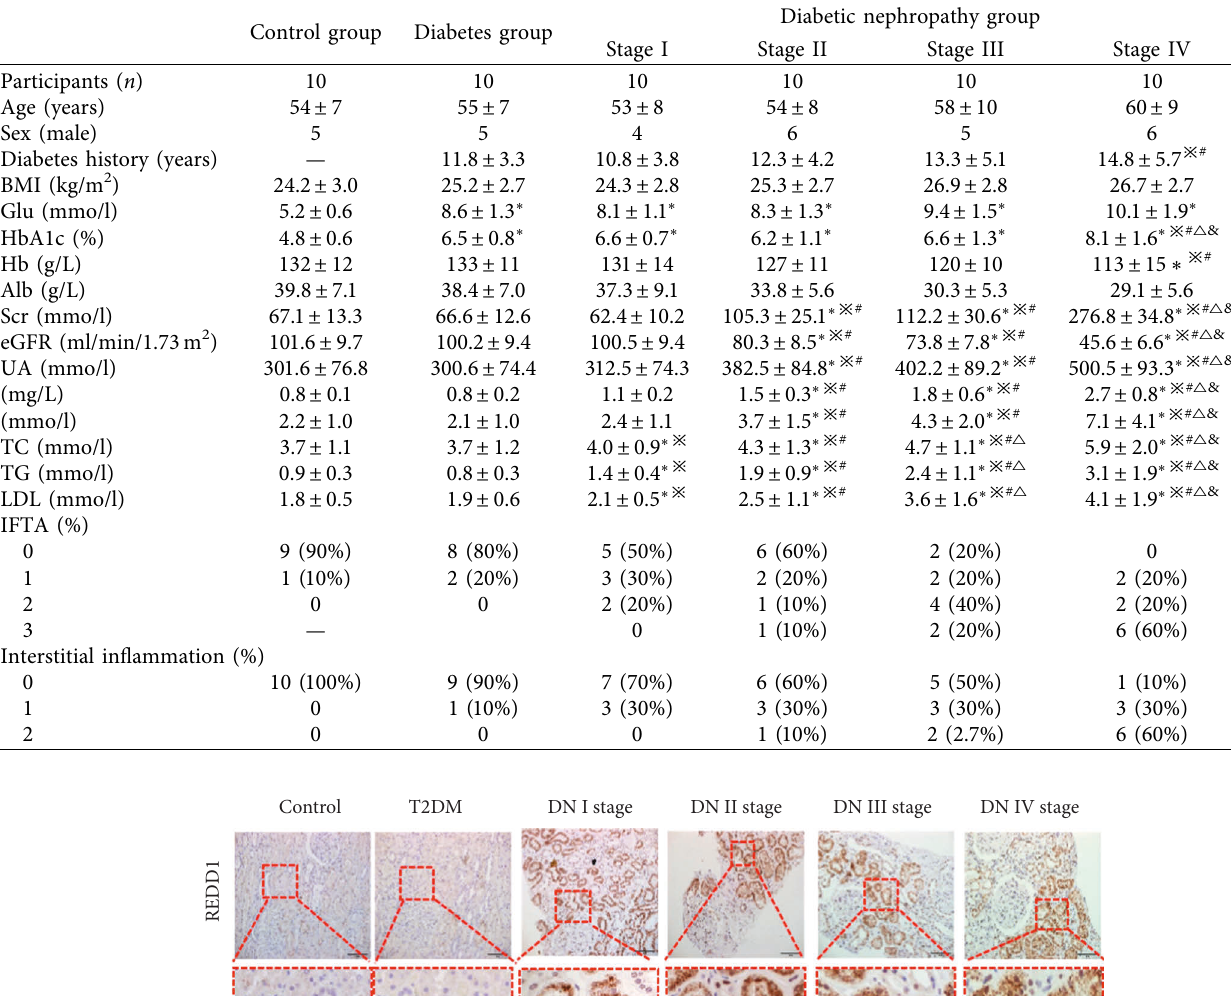
number. Data presented as means SD or n prevalence. Glu: (cid:31) ±